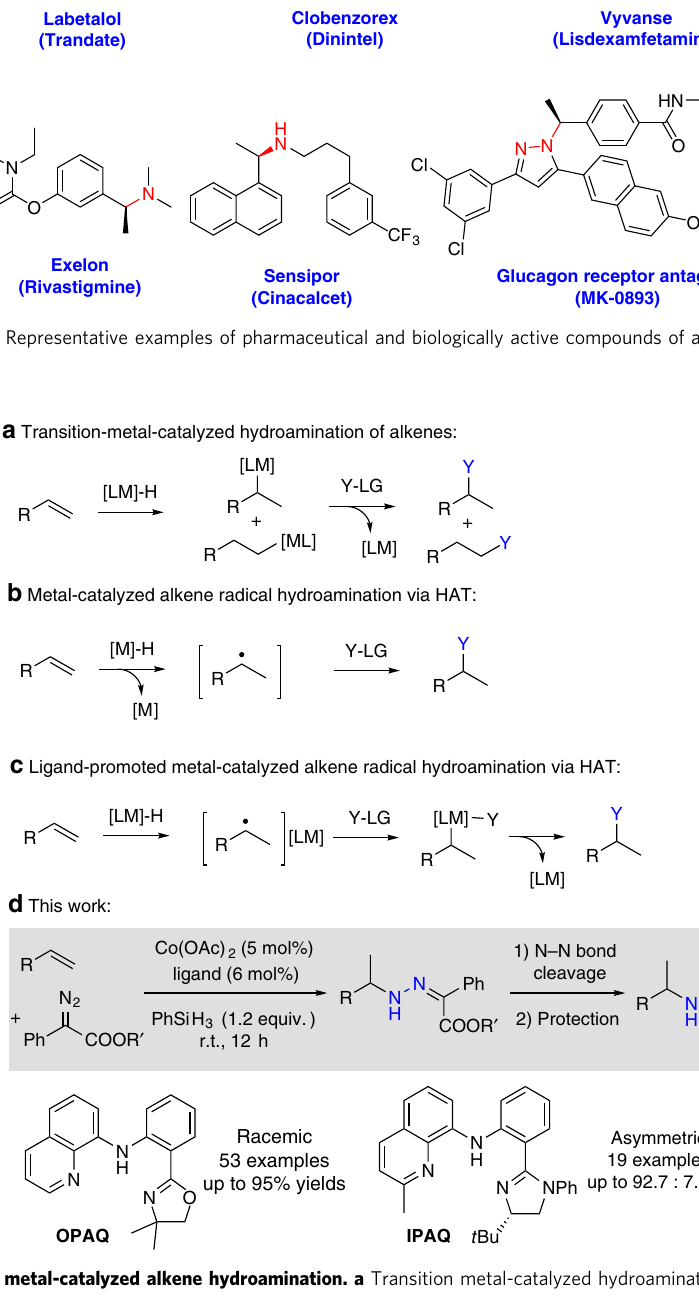
Fig. 2 Strategies for transition metal-catalyzed alkene hydroamination. a Transition metal-catalyzed hydroamination of alkenes. b Metal-catalyzed radical hydroamination of alkenes. c Ligand-promoted metal-catalyzed alkene radical hydroamination via HAT. d Ligand-promoted metal-catalyzed asymmetric radical hydroamination of alkenes via